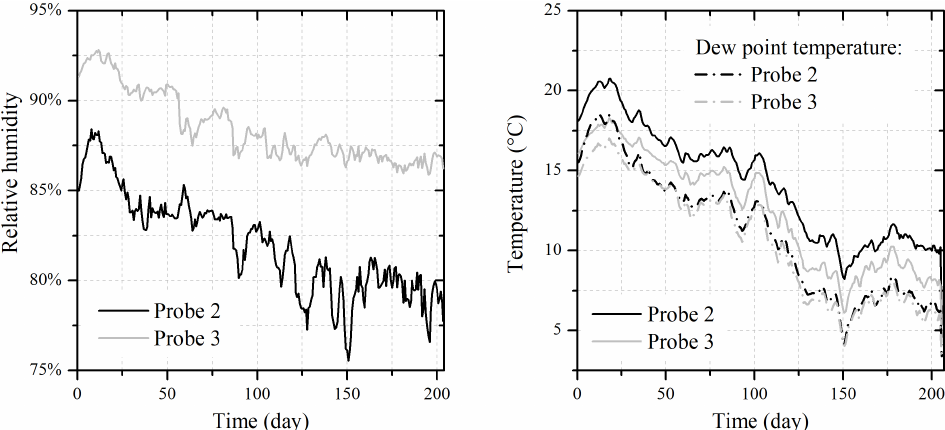
Figure 12. Evolution of relative humidity ( left ) and temperature ( right ) in the ventilated air space: Probe 2 was placed at the bottom of the air space while probe 3 was fixed at the top of the air